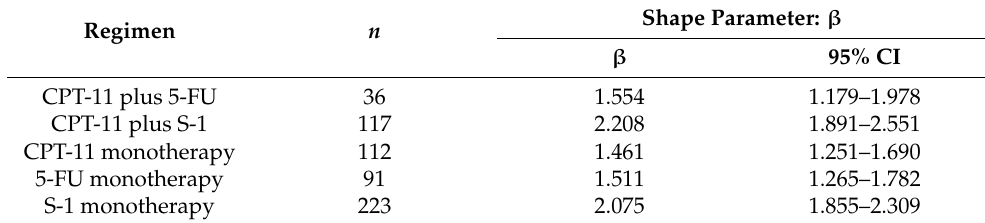
Table 6. Distribution rate related to diarrhea using the Weibull